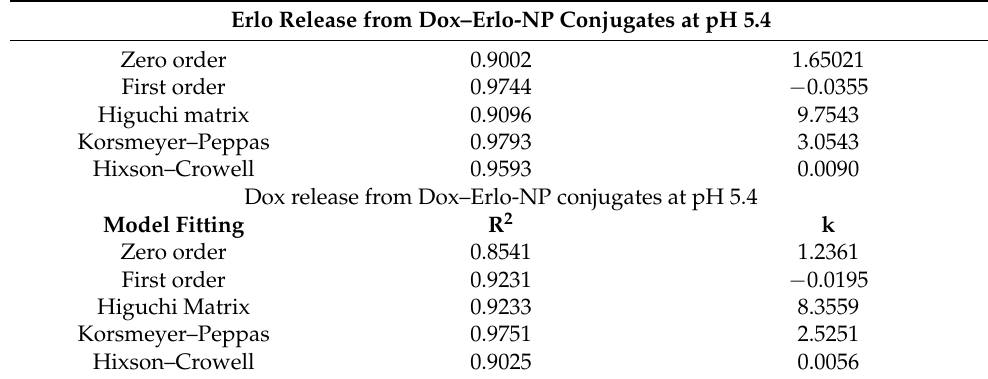
Table 6. Kinetic drug release of Erlo and Dox release from Dox–Erlo-NP conjugates at pH 5.4. Erlo Release from Dox–Erlo-NP Conjugates at pH